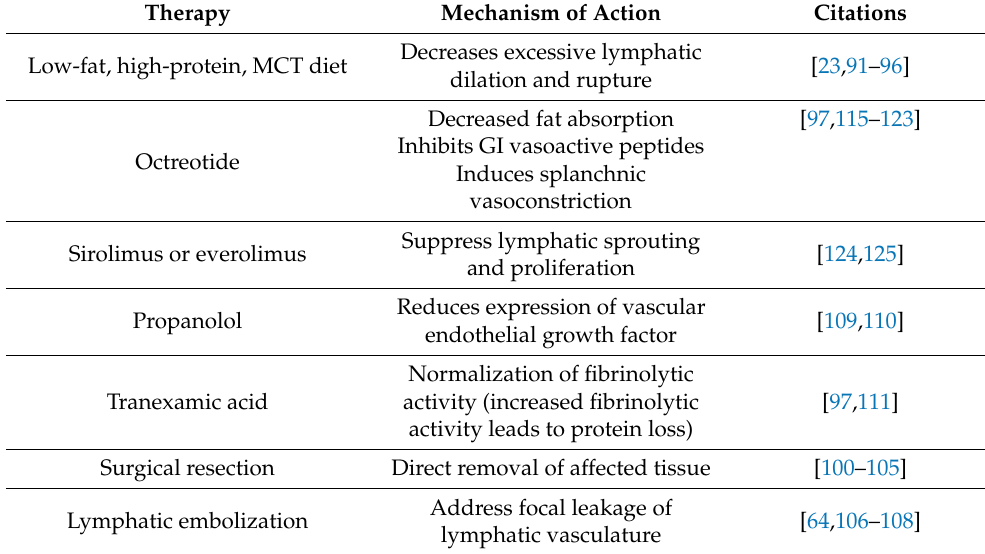
Table 1. Summary of selected therapies for treatment of PIL in